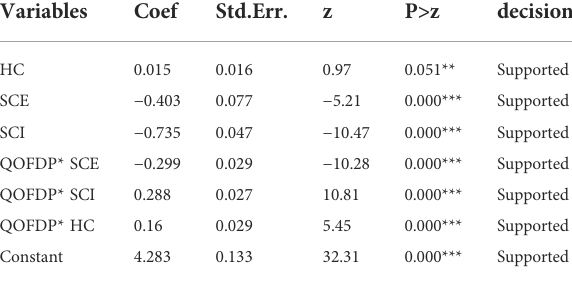
TABLE 5 Path assessment with